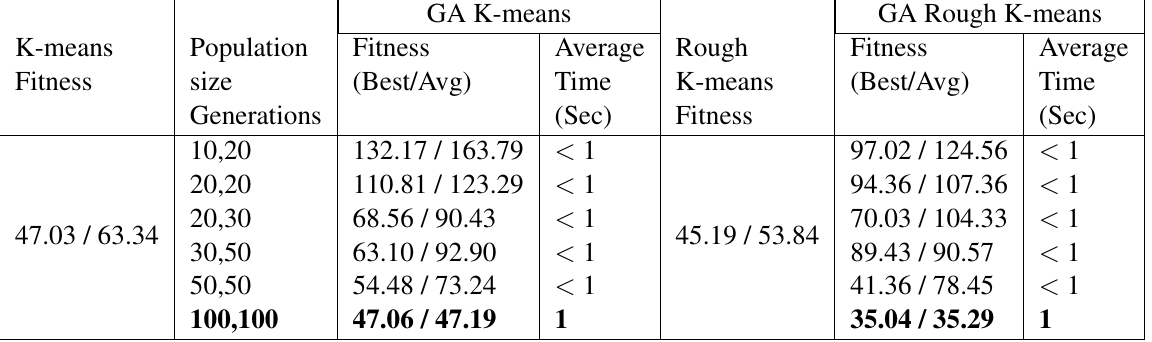
Table 1: Comparison of crisp, rough and evolutionary algorithms for Synthetic data.